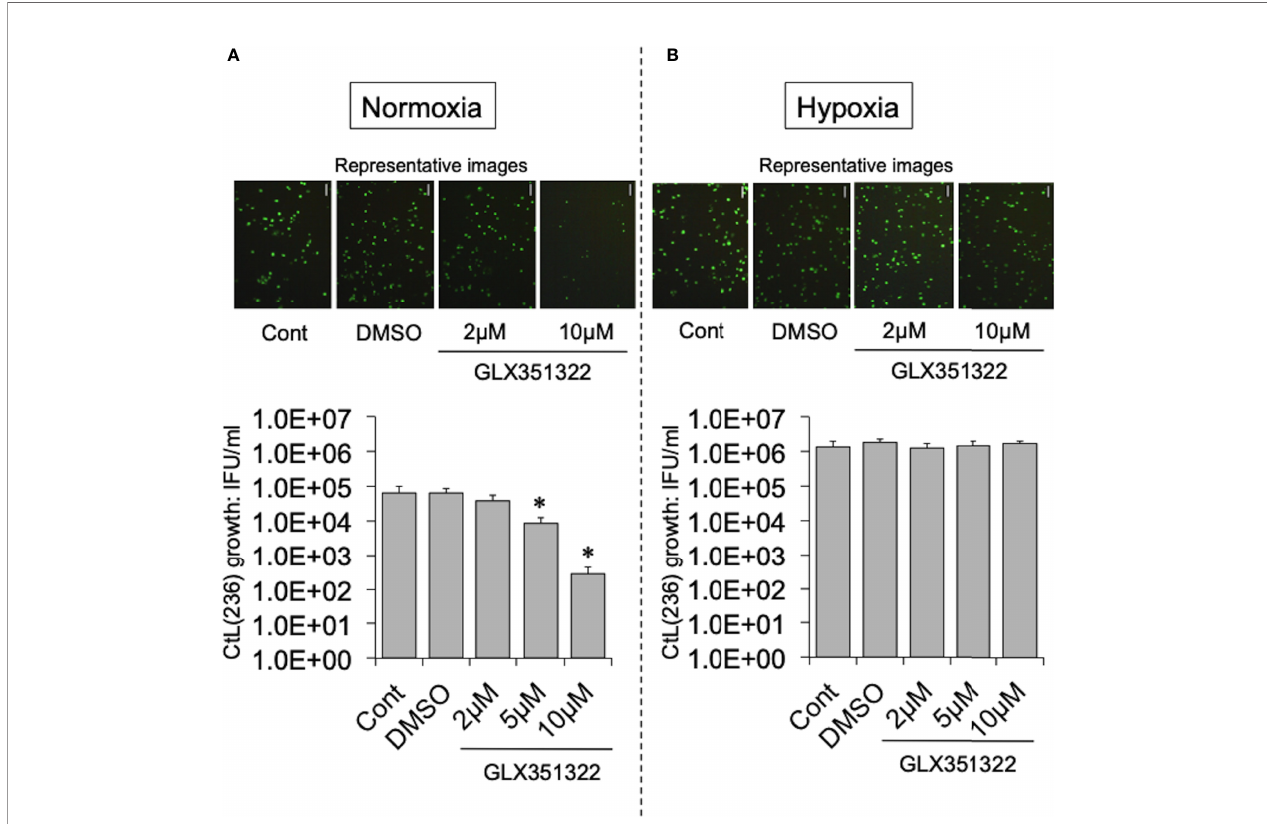
FIGURE 2 | Effect of NOX4-speci fi c inhibitor GLX351322 on the intracellular growth of green fl uorescent protein (GFP)-expressing CtL2 (236) under normoxia (A) and hypoxia (B) . HEp-2 cells were infected at a multiplicity of infection (MOI) = 5 with GFP-expressing CtL2 (236) in the presence or absence of the drug, and cultured for 48 h. Representative images show inclusion bodies (green) formed in infected HEp-2 cells. Bars = 100 m m. The number of bacteria was calculated by inclusion-forming unit (IFU) assay of infected cells cultured for 48 h. Data show means ± SD obtained from at least three experiments. * p < 0.05 vs. the value for each control